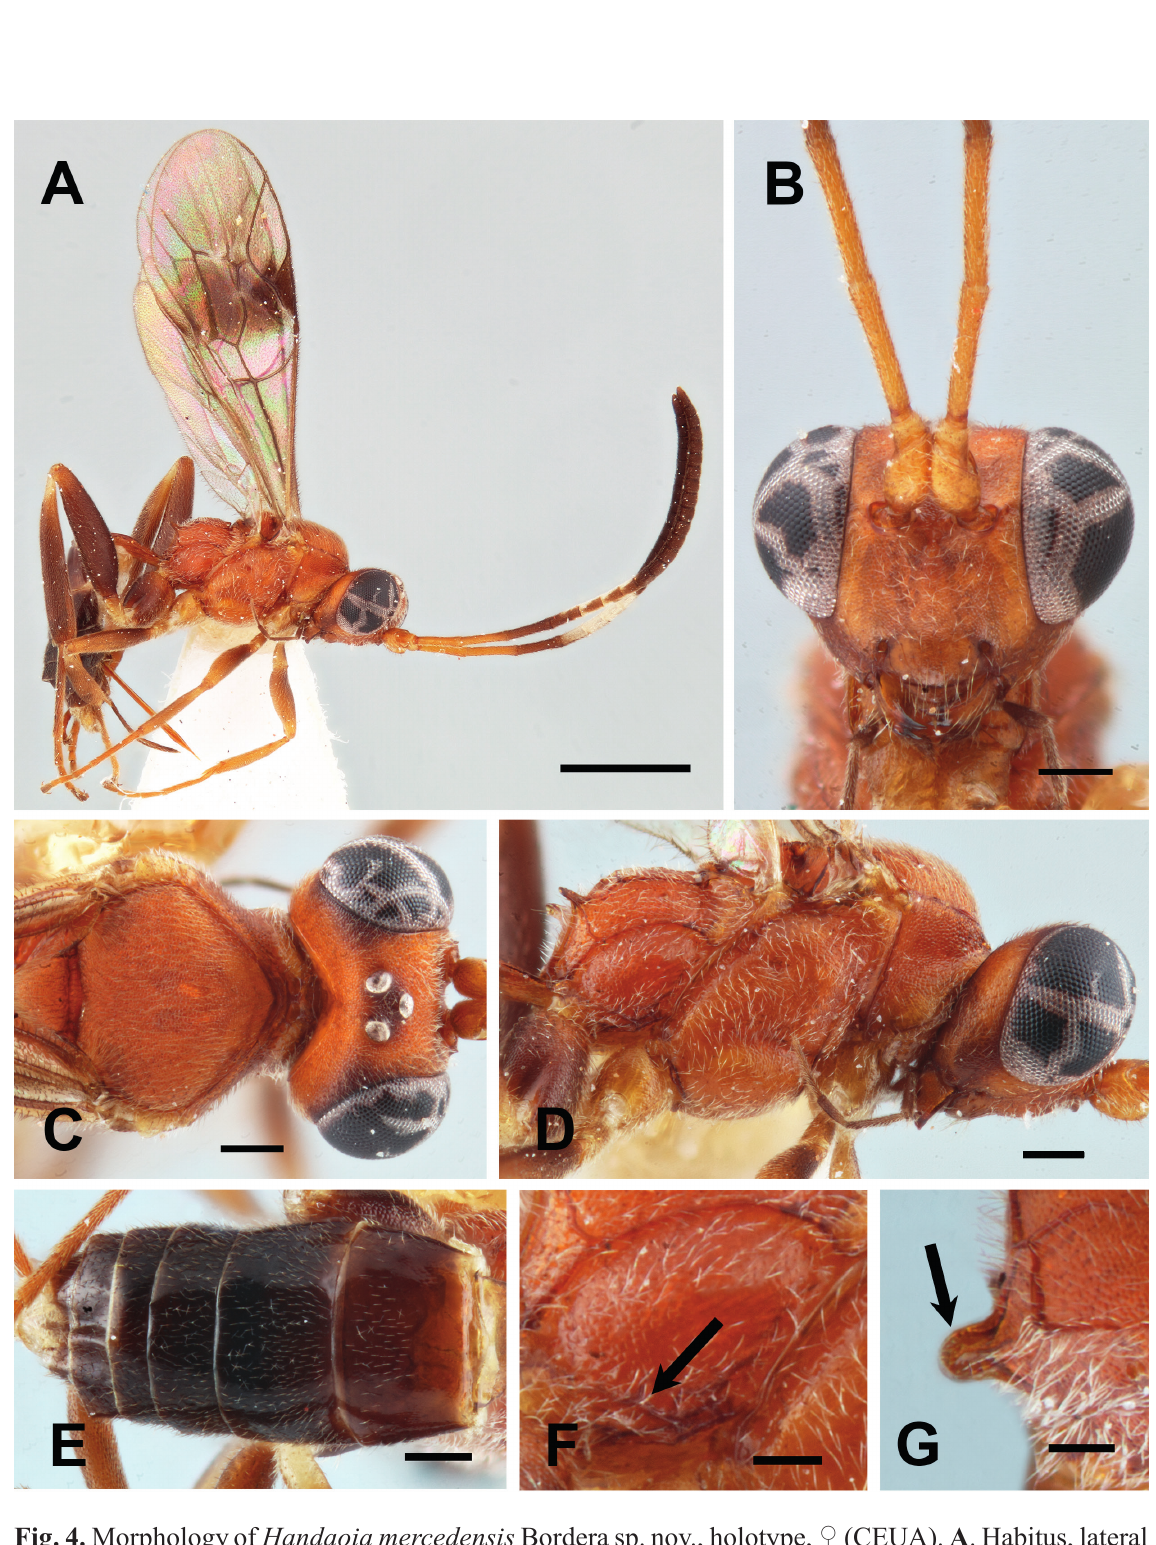
Fig. 4. Morphology of Handaoia mercedensis Bordera sp. nov., holotype, ♀ (CEUA). A . Habitus, lateral view. B . Head, front view. C . Head and mesoscutum, dorsal view. D . Head and mesosoma, lateral view. E . Metasoma, dorsal view. F . Metapleuron (arrow: juxtacoxal carina). G . Propodeum (arrow: propodeal apophysis). Scale bars: A = 1 mm; B–E = 0.2 mm; F–G = 0.1